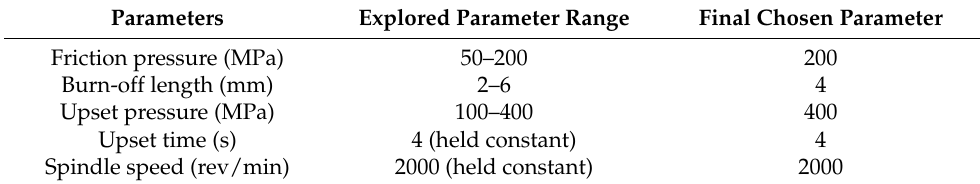
Table 2. Friction welding